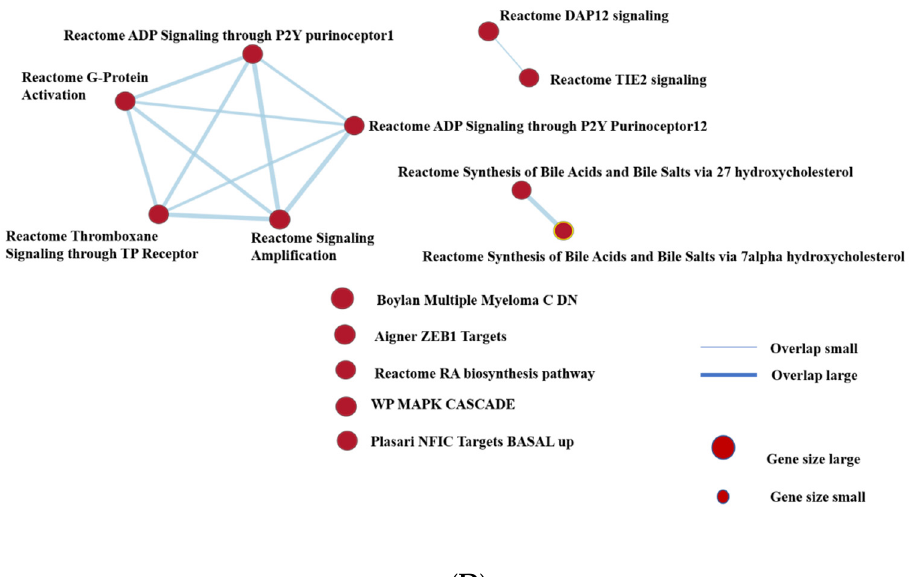
Figure 5. ( A ) Transcriptome profile comparison between the traditional and the alternative groups. The expression of a number of genes was significantly different between the two groups. Red = upregulated genes. Blue = downregulated genes; ( B ) mTOR signaling and PI3K/AKT pathways were significantly enriched in traditional; ( C ) significant enriched the signaling pathways in traditional treatment. The size of the circle denotes the relative number of genes in each pathway; ( D ) signaling enrichment analysis performed using Reactome analysis showed comparable pathways to the H collection analysis. It showed additionally that groups of these pathways form Reactome functional interaction networks, as indicated by the connecting lines.